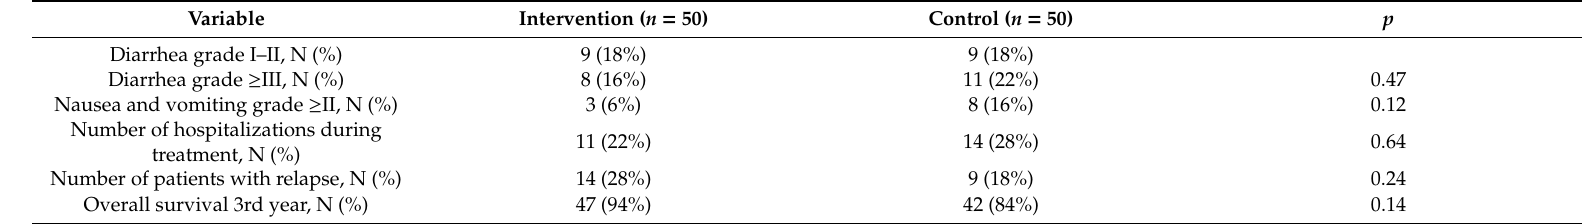
Table 5. Clinical parameters